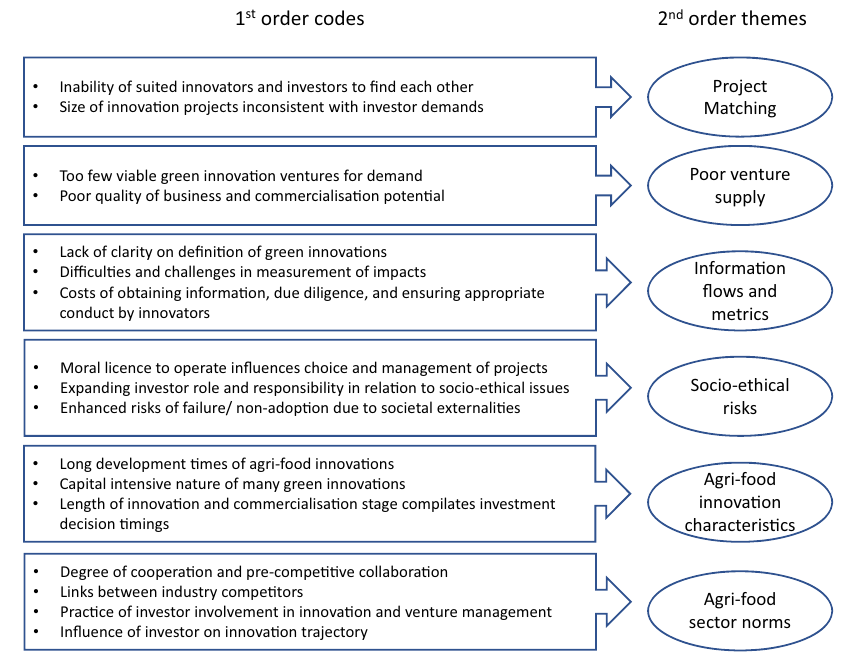
Fig. 1 Overview of Results. This fi gure highlights the 1st order codes that emerged through the data analysis and the subsequent 2nd order